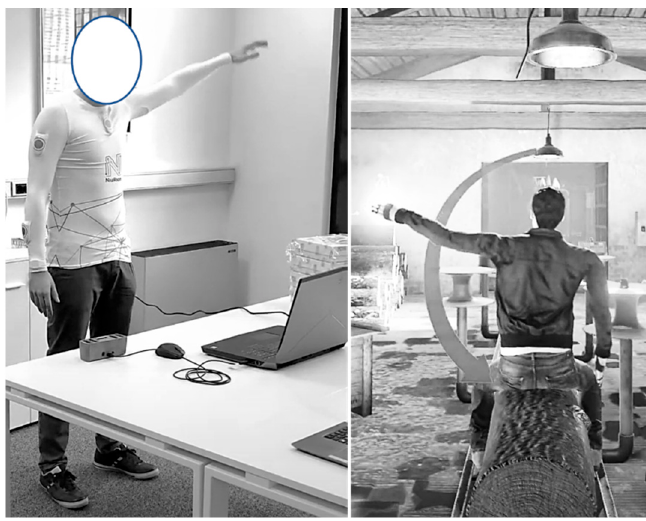
Figure 2. Example of shoulder 180° abduction exercise execution with related avatar